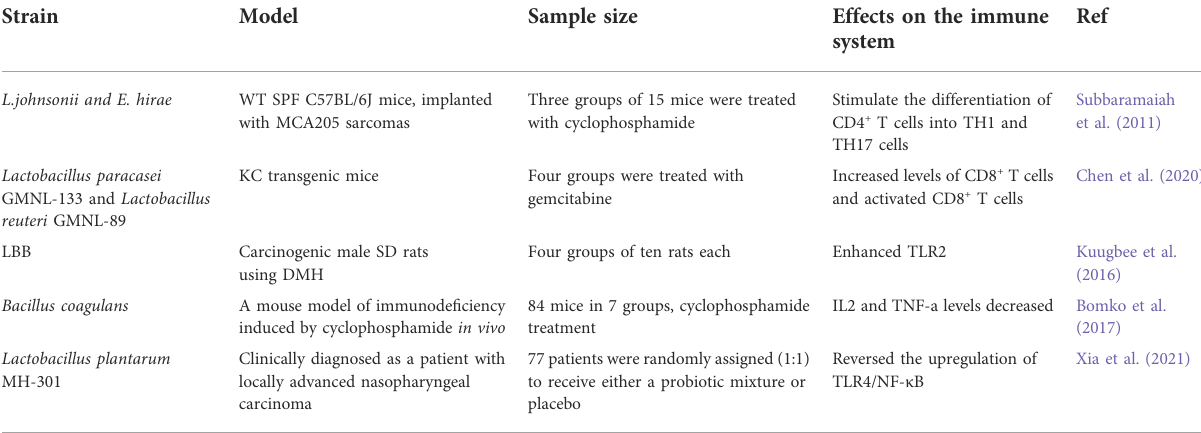
TABLE 2 Effects of probiotic strains on anti-cancer immune